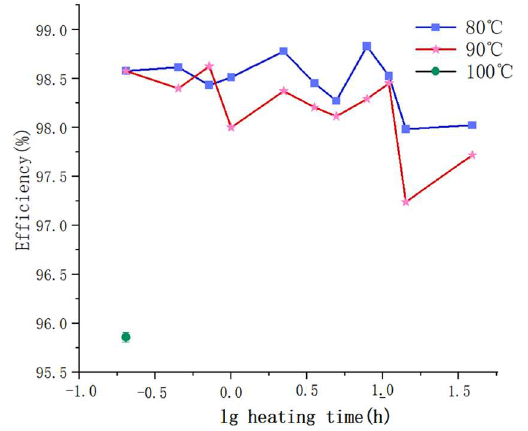
Figure 12. A comparison of the neural network prediction results and experimental